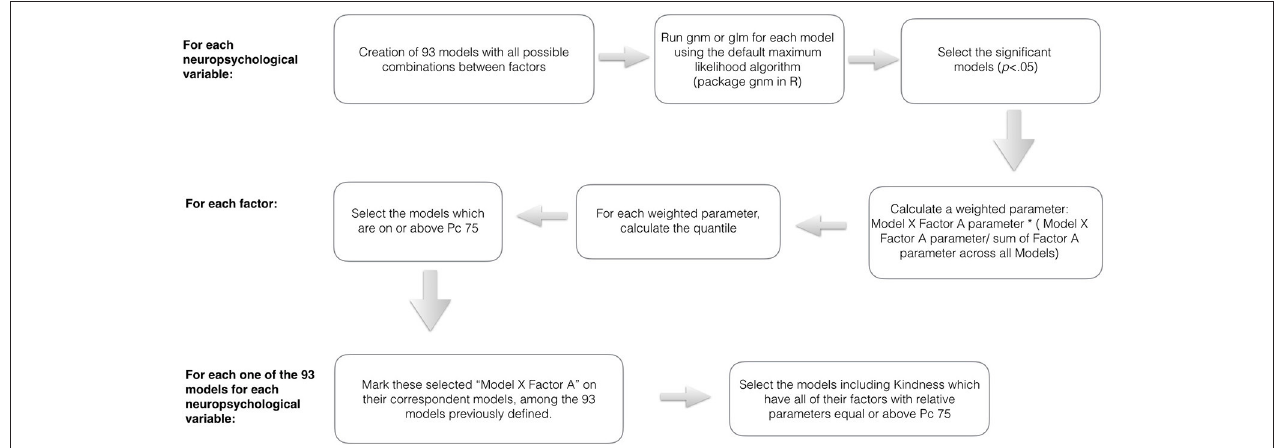
FIGURE 1 | Schematic illustration of the data analysis steps toward the identification of harmonic and contextualized